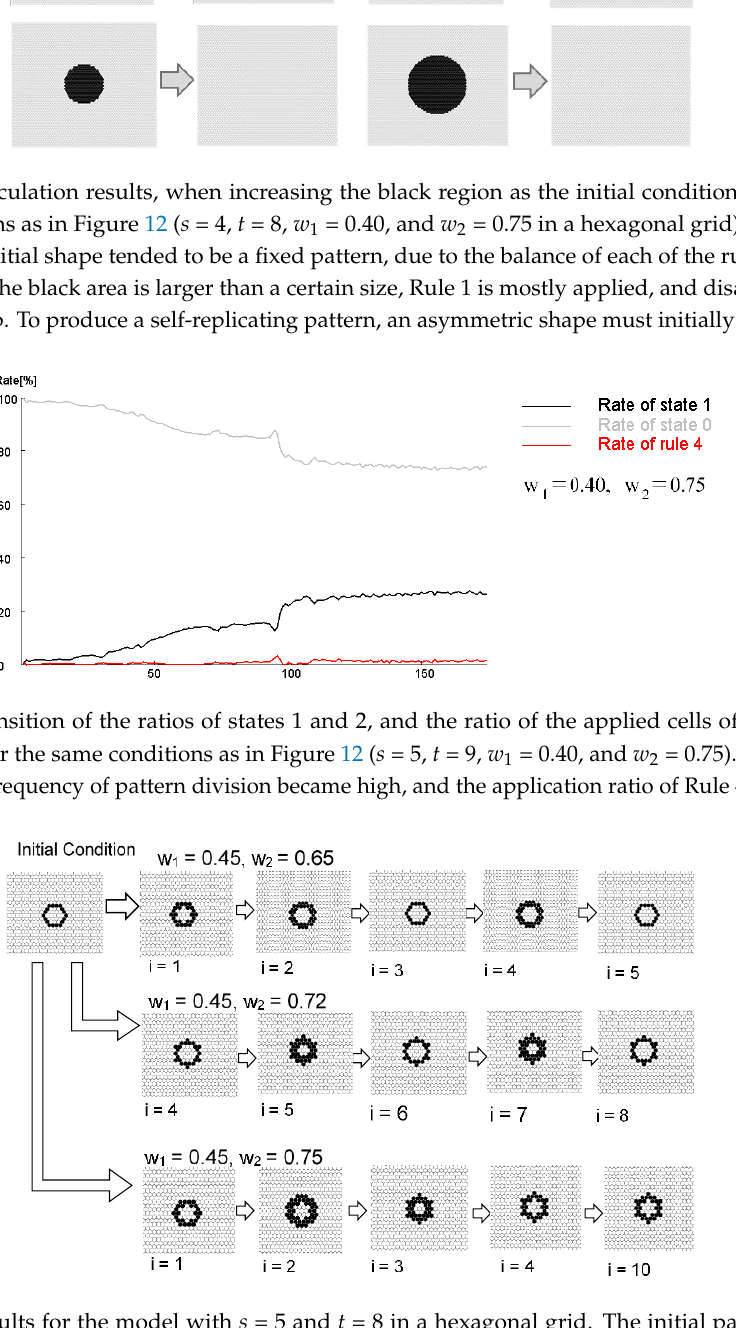
Figure 16. Results for the model with s = 5 and t = 8 in a hexagonal grid. The initial pattern was a symmetrical ring. When w 1 = 0.45 and w 2 = 0.65, the ring pattern became an oscillation pattern with period 2. When w 1 = 0.45 and w 2 = 0.72, the ring pattern likewise became an oscillation pattern with period 2. When w 1 = 0.45 and w 2 = 0.75, a still pattern was formed.